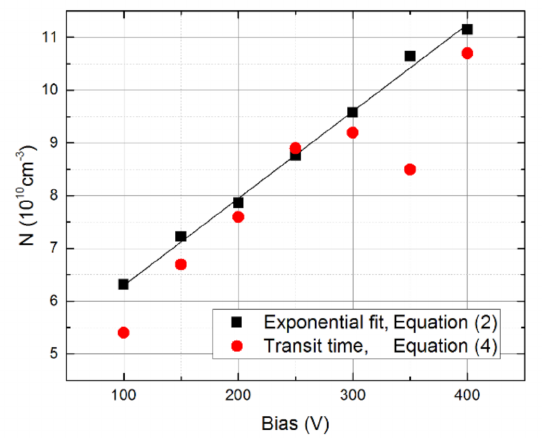
Figure 13. Bias dependence of the normalized space charge density in AC2 derived from the CWF slope (black squares) and from the transit time (red bullets). Linear fit corresponds to the equation N (cm − 3 ) = 4.62 × 10 10 + 1.65 × 10 8 × Bias